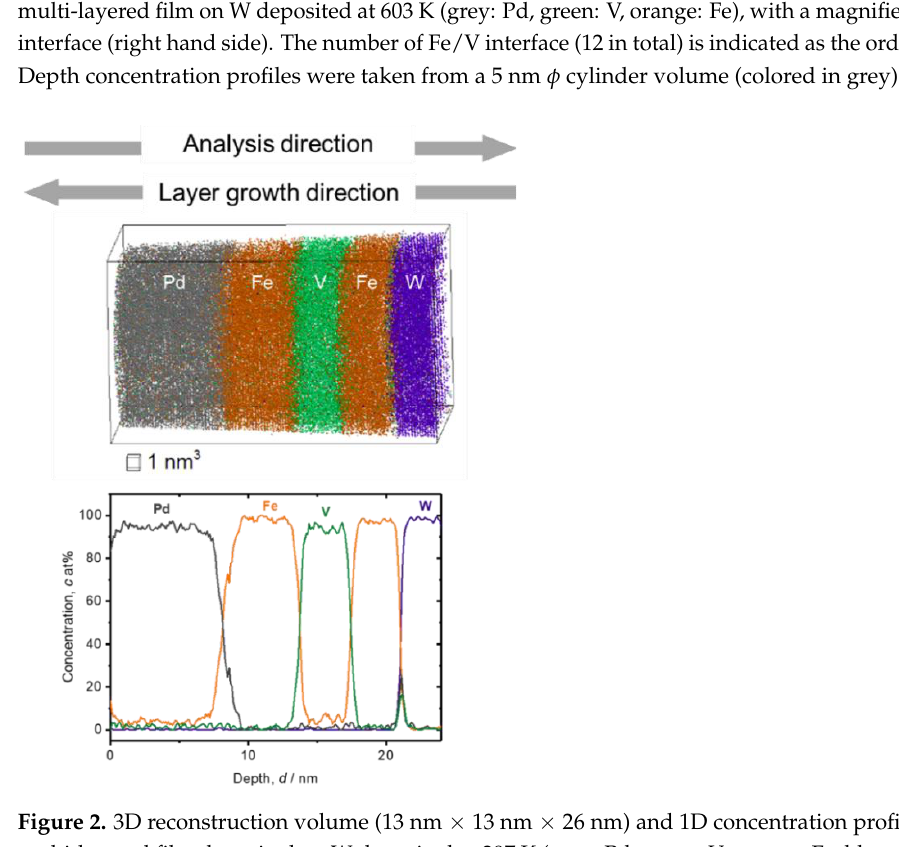
Figure 3. Low temperature part of Fe-V binary phase diagram [31]. 603 K and 297 K are indicated by horizontal orange lines. Fe solubility limit (orange) and V solubility limit (green) at each temper- ature are marked by individual filled circles. 2.1.2. Interface Intermixing by Sputtering Process In Figures 4 and 5, the magnified V/Fe/V region is shown for the films deposited at 603 K and at 297 K, respectively. According to these profiles, depending on the sequence, the intermixing depth can be estimated as wide as 2 nm when deposited at 603 K (Figure 4). This value is almost twice as the mixing regime at 297 K, which is only 1.0~1.1 nm (Figure 5). In Figure 4, some changes in the concentration slope can be seen between the 2 nd and the 6 th Fe/V interface. However, there is no systematic change in the slope in the course of deposition even at the high temperature of 603 K. Therefore, interdiffusion processes solely cannot be convincingly attributed for the explanation. We should note that the field evaporation sequence in atom probing can also be affected by local chemistry via modifi- cation of the field evaporation strength E F . The change in E F sometimes induces a signifi- cant deviation from the original position of atoms. In this case, special care must be taken by examining the interface of two different layers [32 – 34]. Indeed, the E F of Fe 2+ (30 V/nm)